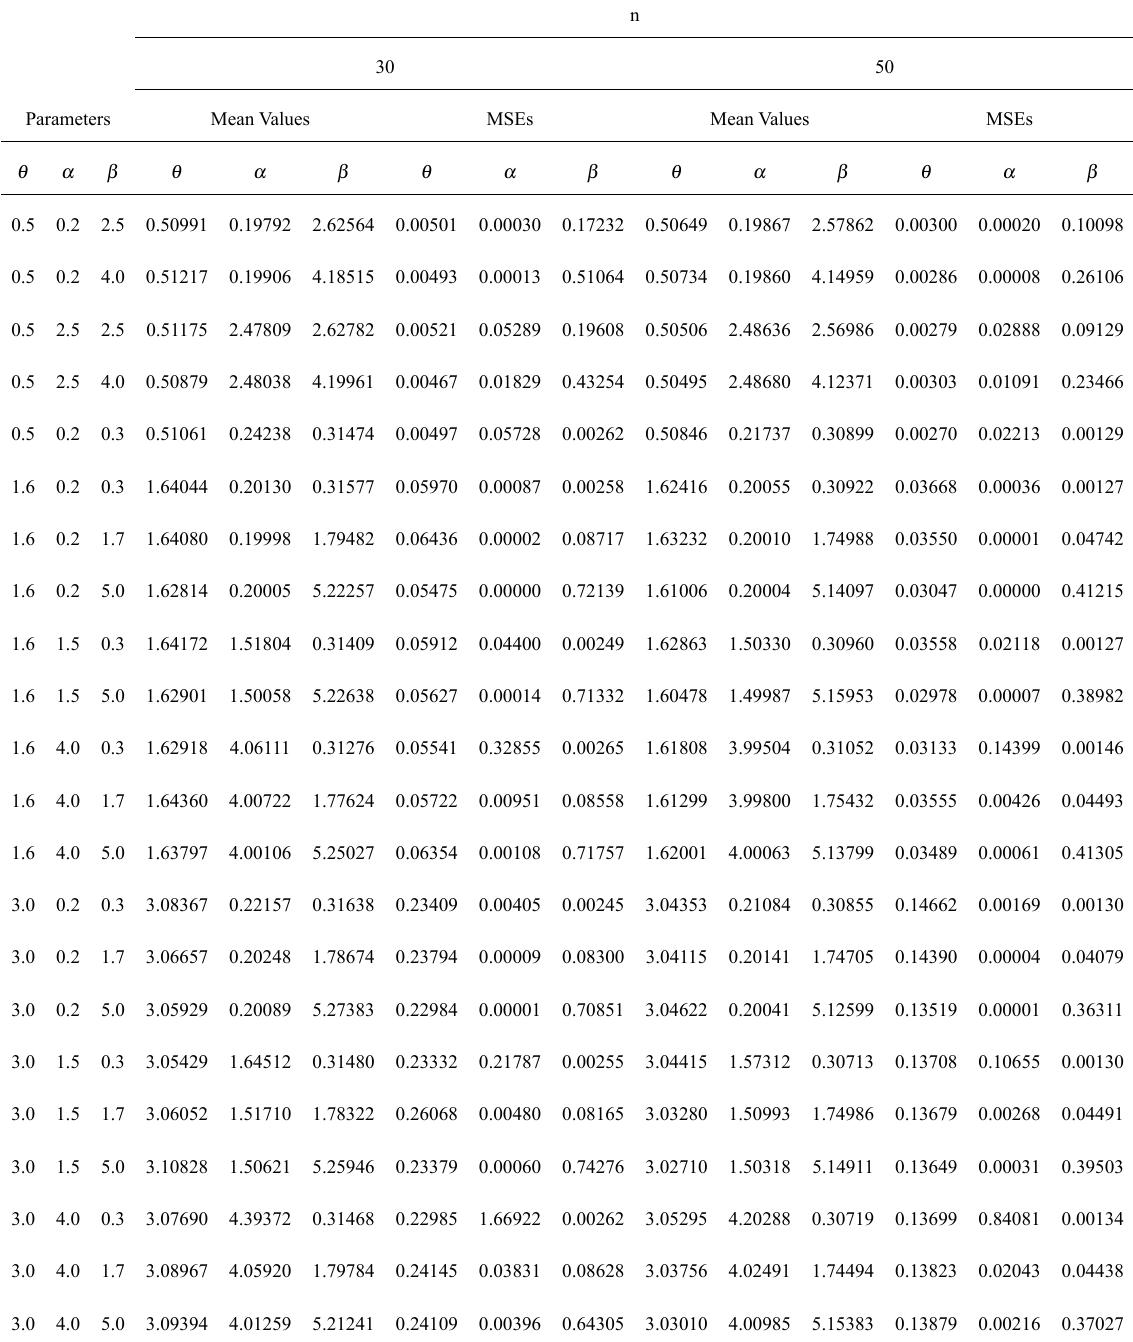
The mean values and MSEs based on 1,000 simulations of the LiW.